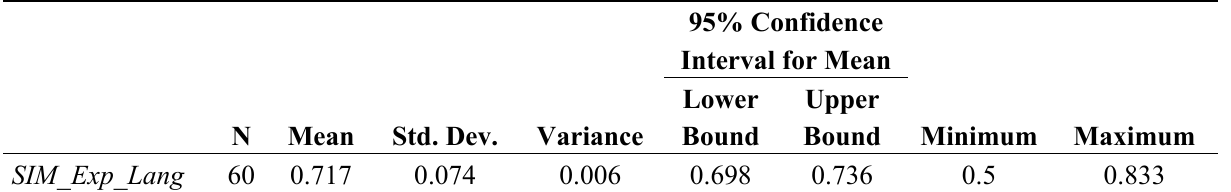
Table 11. Descriptive Statistics of the SIM_Exp_Lang